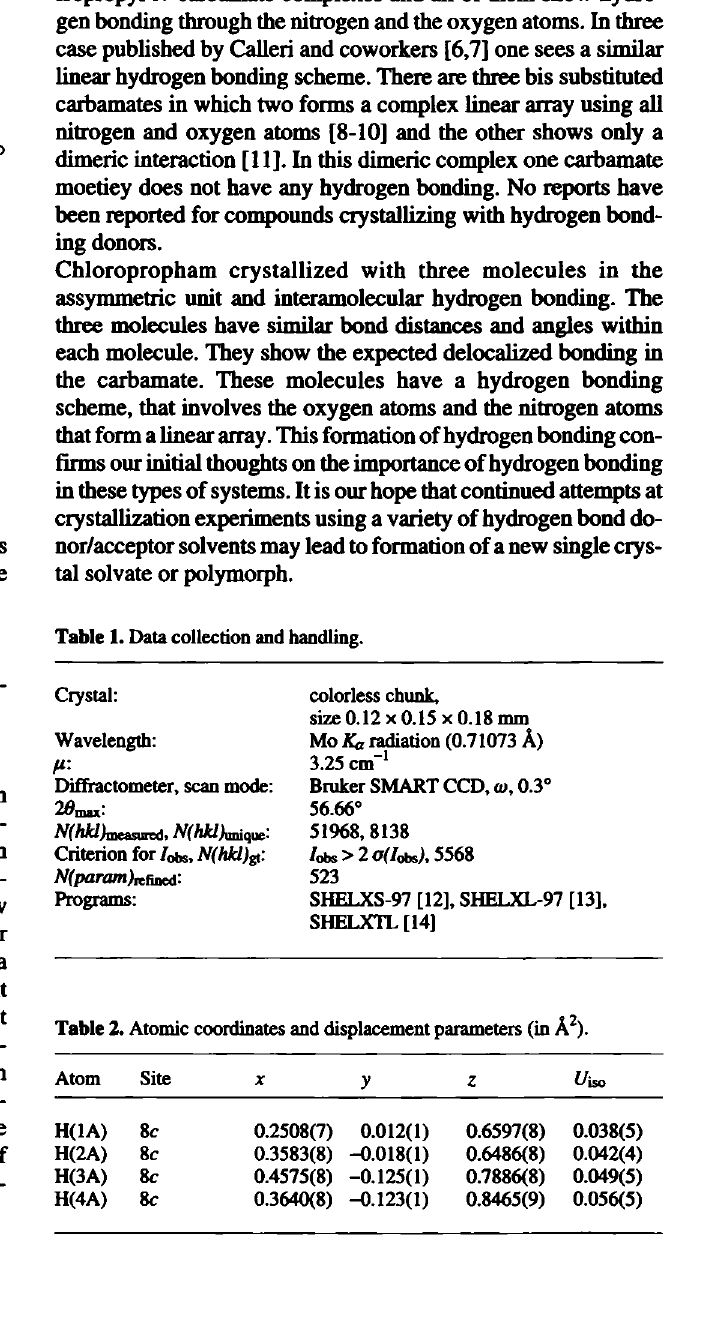
Table 2. Atomic coordinates and displacement parameters (in Â 2